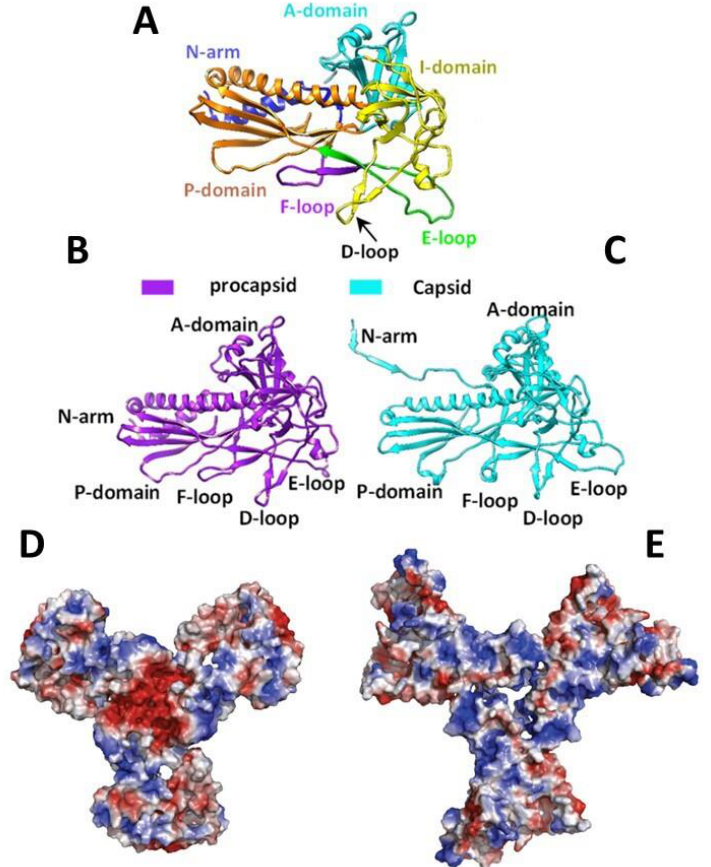
Figure 3. P22 phage coat protein. ( A ) The coat protein monomer is divided into six domains: A- domain, P-domain, N-arm, E-loop, F-loop, and I-domain (D-loop is part of I-domain). ( B ) Immature conformation that is present on PC and ( C ) mature conformation that is present on mature capsid after the dsDNA encapsulation ( D , E ) (adapted from [52]). Structure of the “trimer tips”, the meeting point of three hexamers (threefold axis) in ( B ) PC, and ( C ) mature capsid of the three-point axis as viewed from the capsid interior. ( C , D ) Structure of the “trimer tips”, the meeting point of three hexamers (threefold axis) in ( C ) PC, and ( D ) mature capsid of the three-point axis as viewed from the capsid interior. The colors represent the surface charge densities of the CP, with red regions representing the negatively charged residues, blue regions representing the positively charged residues, and white regions representing the neutral residues (adapted from